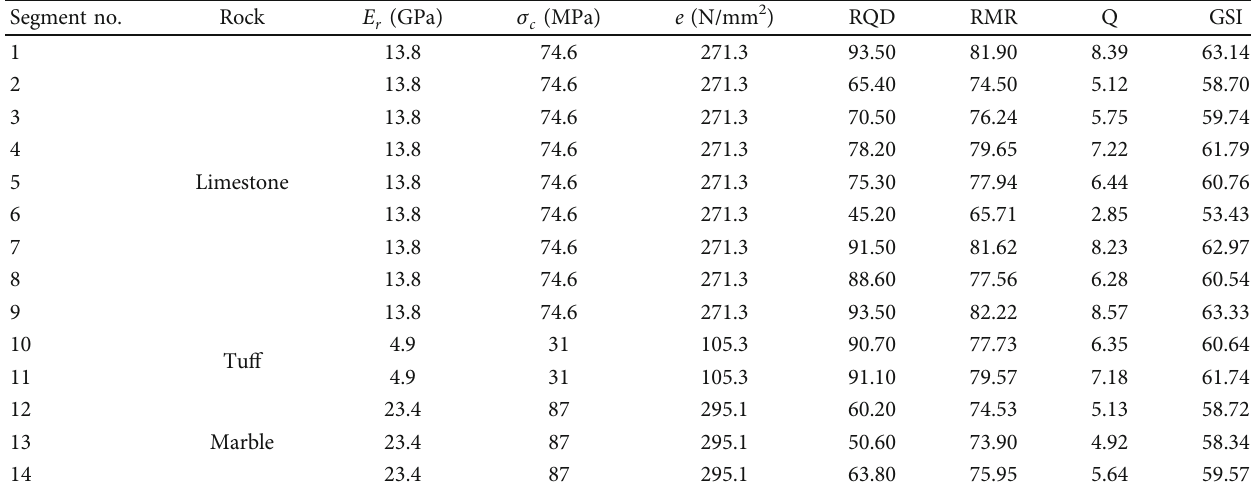
/ σ cm c versus RQD relations and suggestions by Ramamurthy [52], Singh et al. [67], and Singh Table 4: Summary of rock properties at the site.